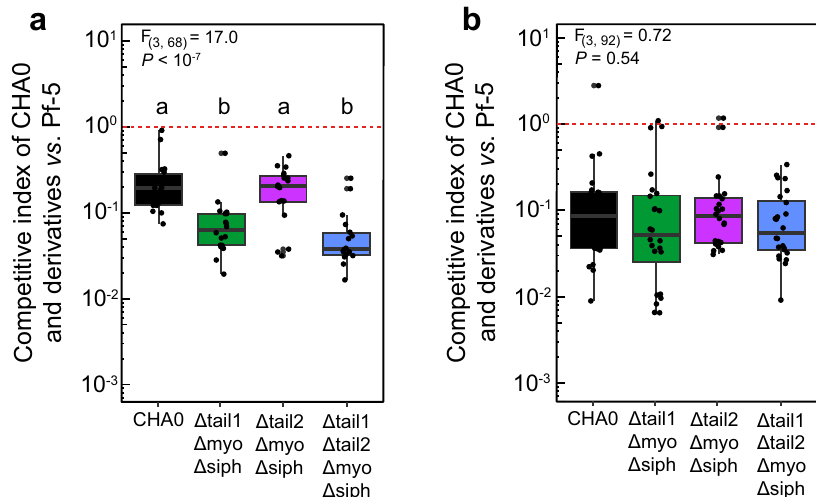
Fig. 7 Tailocin #1 contributes to the competitiveness of Pseudomonas protegens CHA0 toward P . protegens Pf-5. The competitiveness of CHA0 wild type and mutants producing exclusively the tailocin #1 ( Δ tail2 Δ myo Δ siph) or the tailocin #2 ( Δ tail1 Δ myo Δ siph), or none of the viral particles ( Δ tail1 Δ tail2 Δ myo Δ siph) was assessed in 1:1 mixtures with Pf-5 during 24 h in liquid ( a ) and on solid ( b ) media. The red dotted line indicates a competition where both strains would not be in fl uenced by the presence of one another. Statistical differences between the competitive indices of CHA0 wild type and mutants in confrontation with Pf-5 were assessed by ANOVA coupled with Tukey ’ s HSD test and are indicated with letters a and b. n = 8 biological independent experiments were performed with each 3 technical replicates. The boxes indicate the interquartile range with the center representing the median. The detailed results used for this fi gure can be found in the Supplementary Data